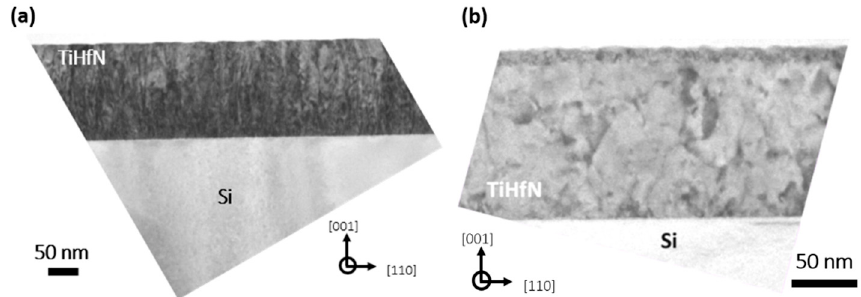
Figure 6. Cross-sectional BF TEM micrographs of ( a ) the as-deposited and ( b ) annealed TiHfN/Si samples taken along the [110] zone axis.